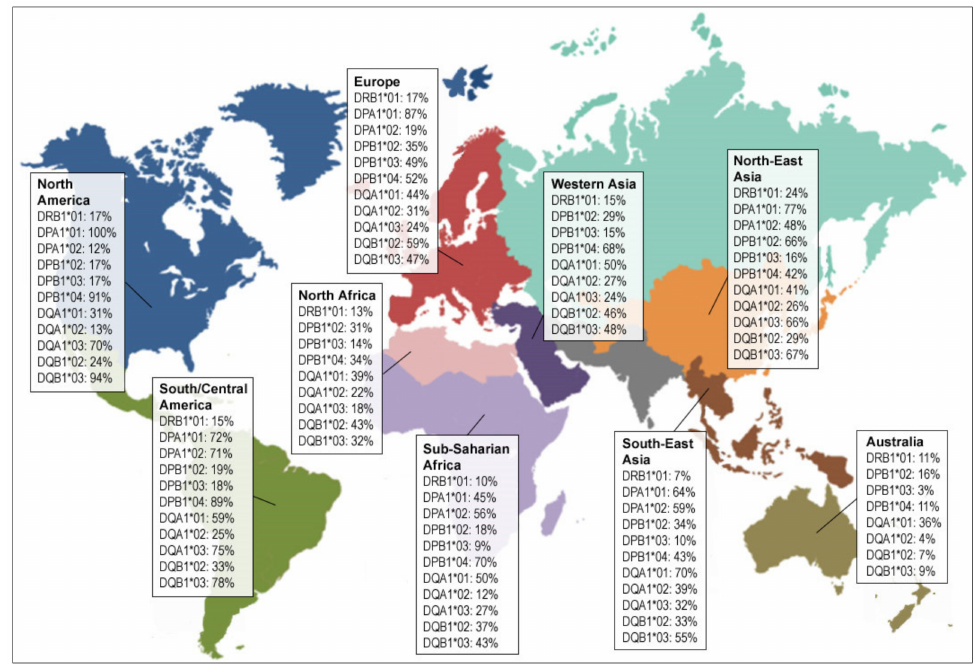
Figure 3. Prevalence of the most common ( ≥ 10% frequency) MHC-II molecules worldwide (according to Allele Frequency Net Database, http: // www.allelefrequencies.net). All class II loci (DRB1, DQA1, DQB1, DPA1, DPB1) were considered in each region available. Alleles with minimum 2 field resolution, ≥ 0.1 allele frequency, and presence in > 50% of regions were retained. Any α / β molecule containing